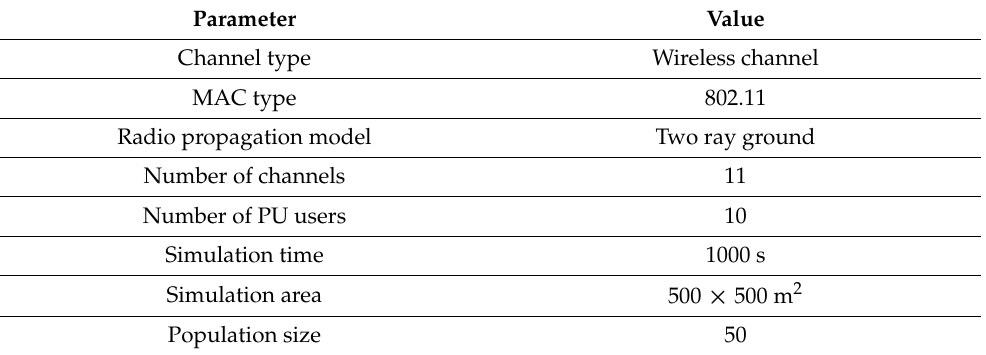
Table 2. Parameter